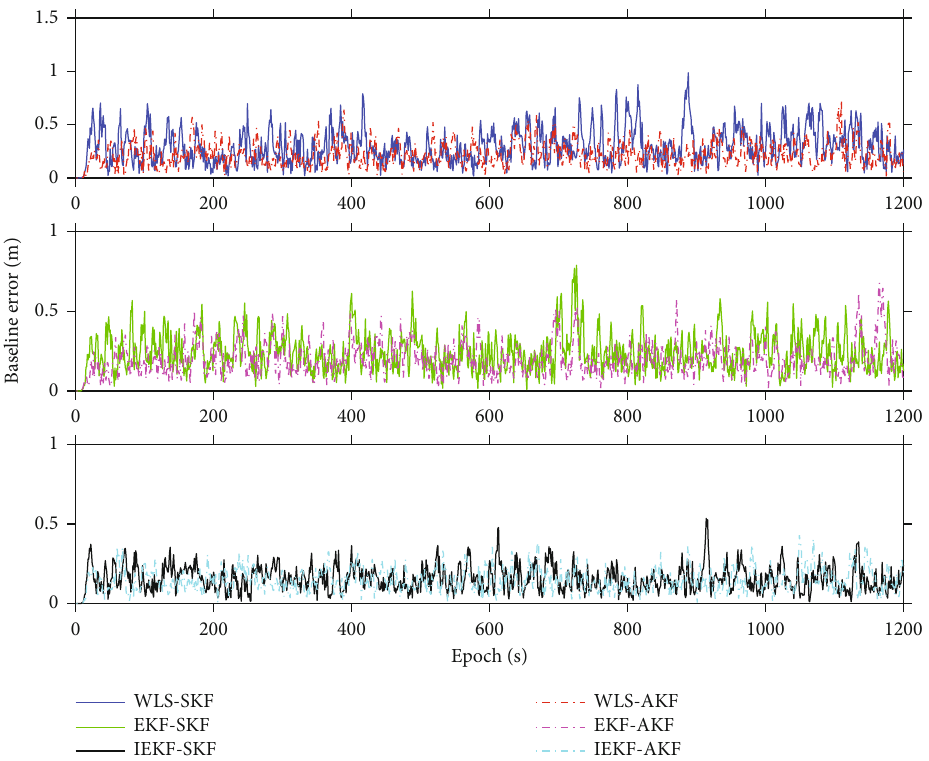
Figure 13: The baseline errors of various algorithms (Data 1).